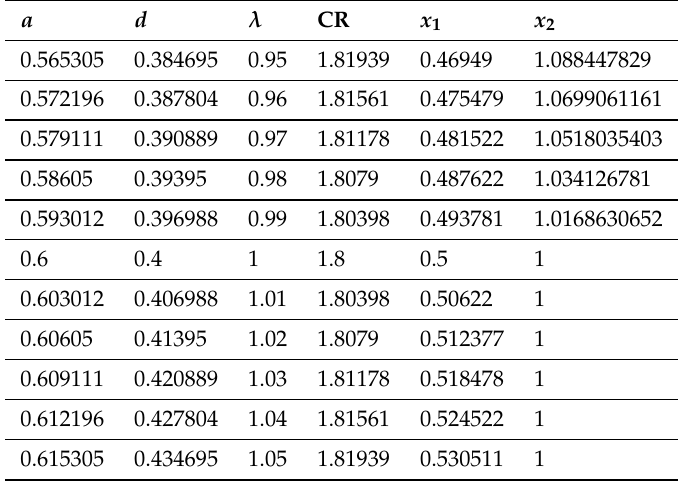
Table 3. Best competitive ratios (CR) together with the corresponding online algorithm for that ratio (defined by switching time values x 1 and x 2 ) for various λ values close to